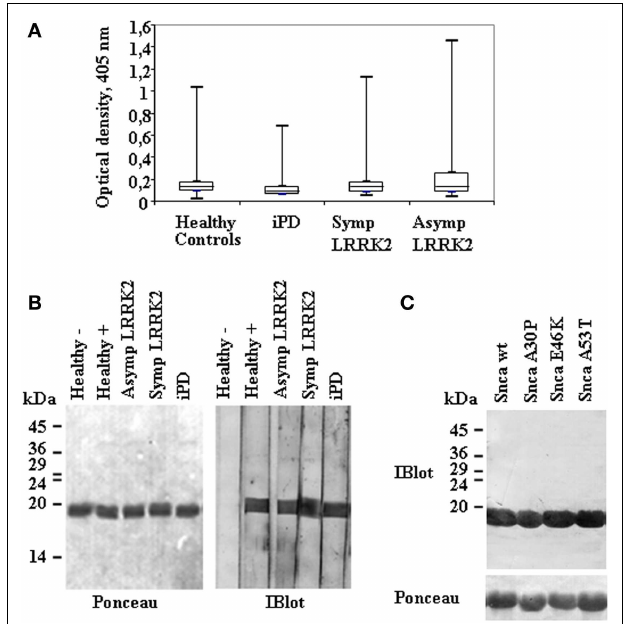
FIGURE 1 |Anti-alpha-synuclein IgG antibodies levels and representative immunoblot analysis of Snca reactivity in patients and healthy controls . (A) A box plot of the results of endpoint readings of ELISA assays for antibodies against alpha-synuclein (Snca). Symbols are as follows: the median, line through the box; upper (q3) and lower (q1) quartiles, upper and lower borders of box, respectively; most extreme non-outlier values, vertical lines; and outliers, maximum and minimum values are represented by dashes for each group of individuals; healthy controls, none manifesting (Asymp) and manifesting (Symp) carriers of the LRRK2 mutation, and idiopathic PD (iPD), as indicated. Differences were not significant by Mann–Whitney U -test. (B) Continuous gels were loaded with purified recombinant Snca and western blotted; and membranes were cut into vertical strips (Ponceau staining) for testing several samples. Individual strips were incubated with plasma at 1/100 dilution.The images show representative results obtained with samples from healthy controls, negative ( − ) or positive ( + ), Asymp and Symp carriers of the LRRK2 mutation, and iPD patients that were all positive for the presence of anti-Snca antibodies. (C) An example of a positive sample tested against purified recombinant Snca wild type (wt) and the missense mutants A30P, E46K, and